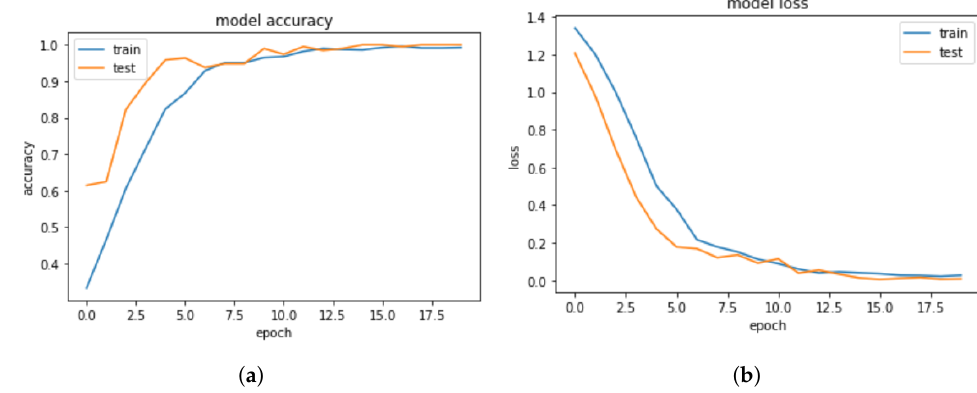
Figure 14. Proposed model accuracy and loss. ( a ) Model accuracy. ( b ) Model